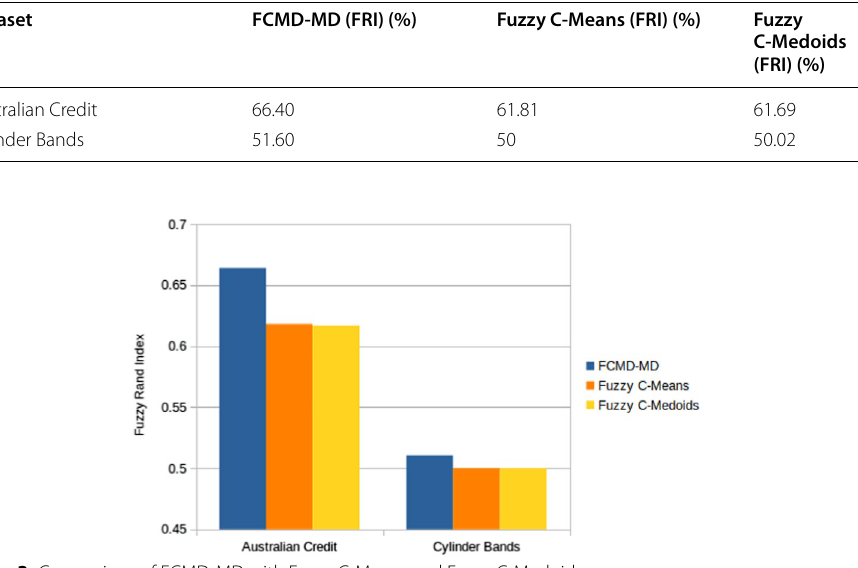
Fig. 3 Comparison of FCMD-MD with Fuzzy C-Means and Fuzzy C-Medoids